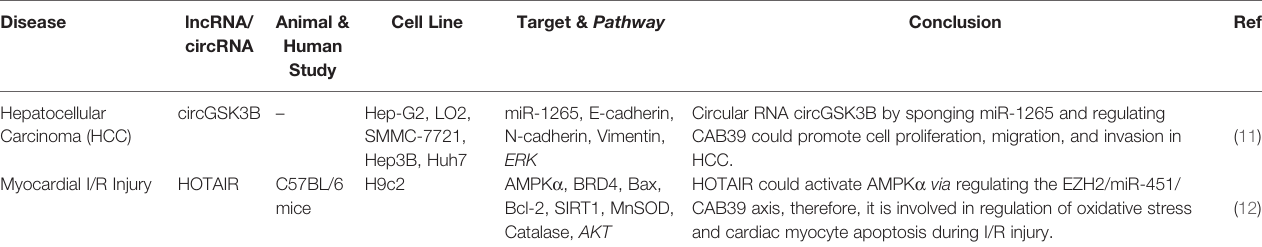
TABLE 2 | CAB39-interacting